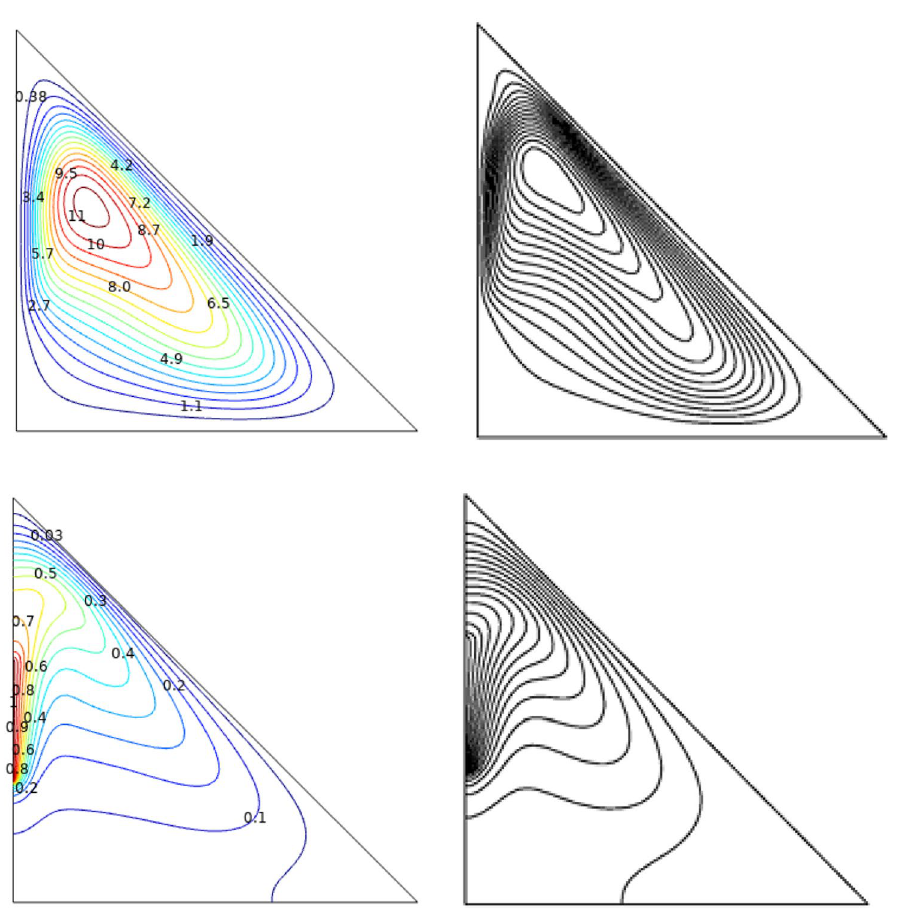
Figure 3. Comparing amongst the current study [right] and the outcomes of Ref. 54 [left] at Ra = 10 6 , Ha = 0